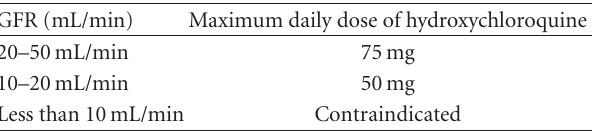
Table 1: Recommended daily dose of hydroxychloroquine accord- ing to the glomerular filtration rate (GFR)